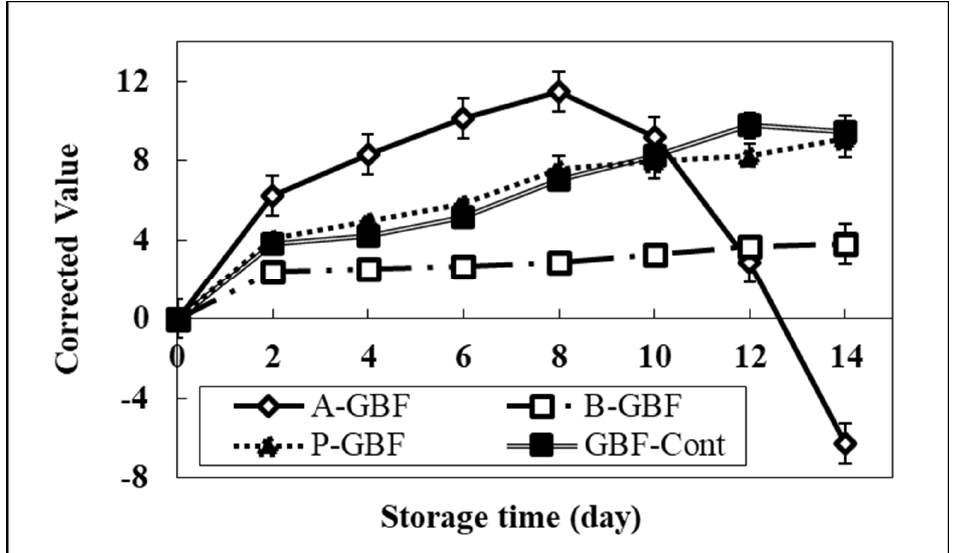
Figure 6. Redness of AES-R systems treated with various GBFs having 0.6% of BHA and phytic acid and 1% of ascorbic acid for 14 days. Herein, all other redness information of GBFs is in Supplemental Figures. Note that GBF-Cont s represents pure GBF while A-, B-, and P- stand for ascorbic acid, BHA, and phytic acid, respectively. Bars indicate the standard deviation.